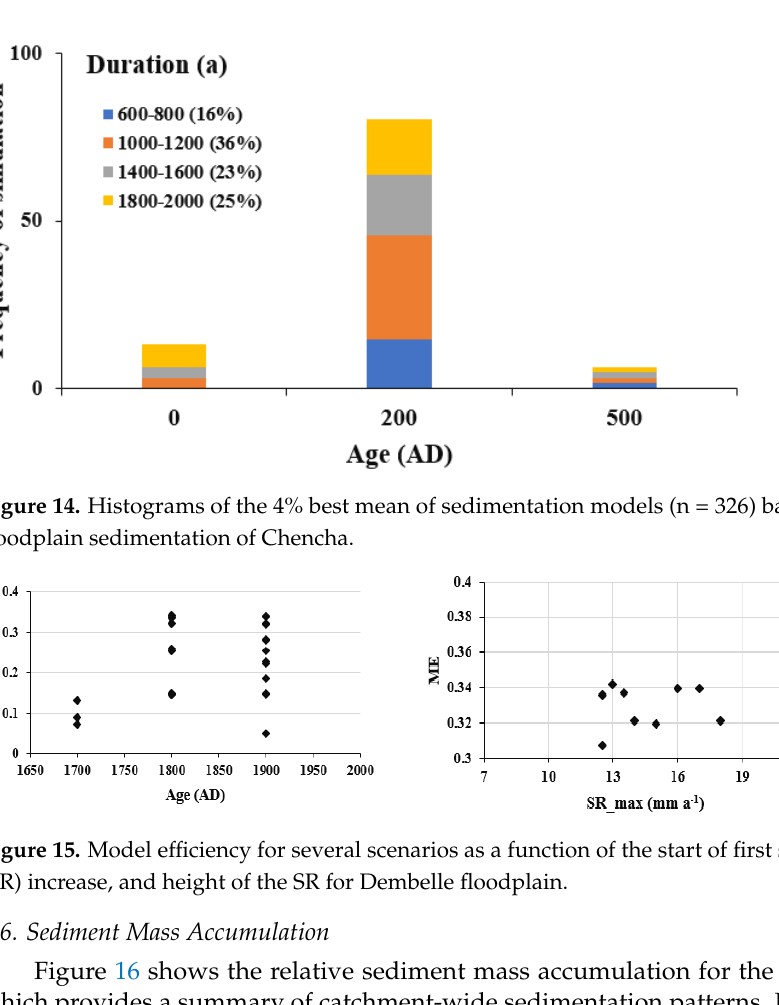
Figure 13. Model efficiency for several scenarios as a function of the ( D ) start of first sedimentation rate (SR) increase, ( E ) start of SR decrease and ( F ) height of the SR for Chencha floodplain .